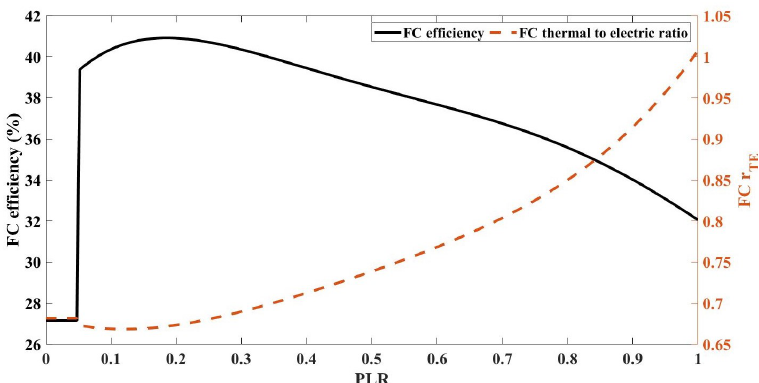
Figure 3. Role of PLR on η FC and r TE . i of Fuel Cell.